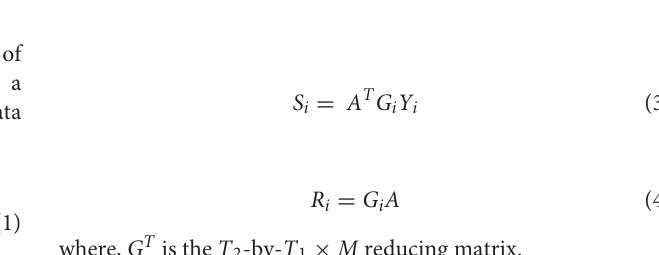
FIGURE 3 | SAR distribution on the transverse slice at the peak value level, for each of the 17 subjects. Square shape delineates the region of pSAR10g on the